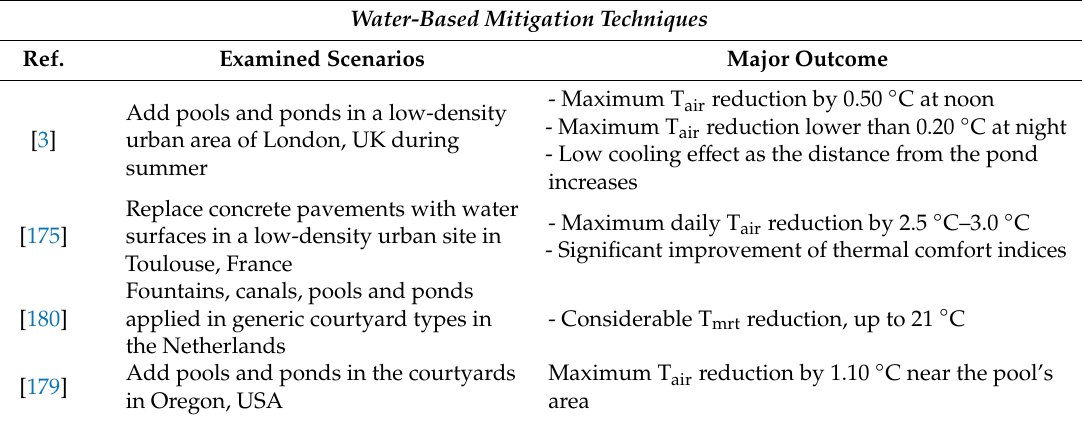
Table 5. Summary of previous studies, assessing the cooling e ff ect of water-based techniques. T air